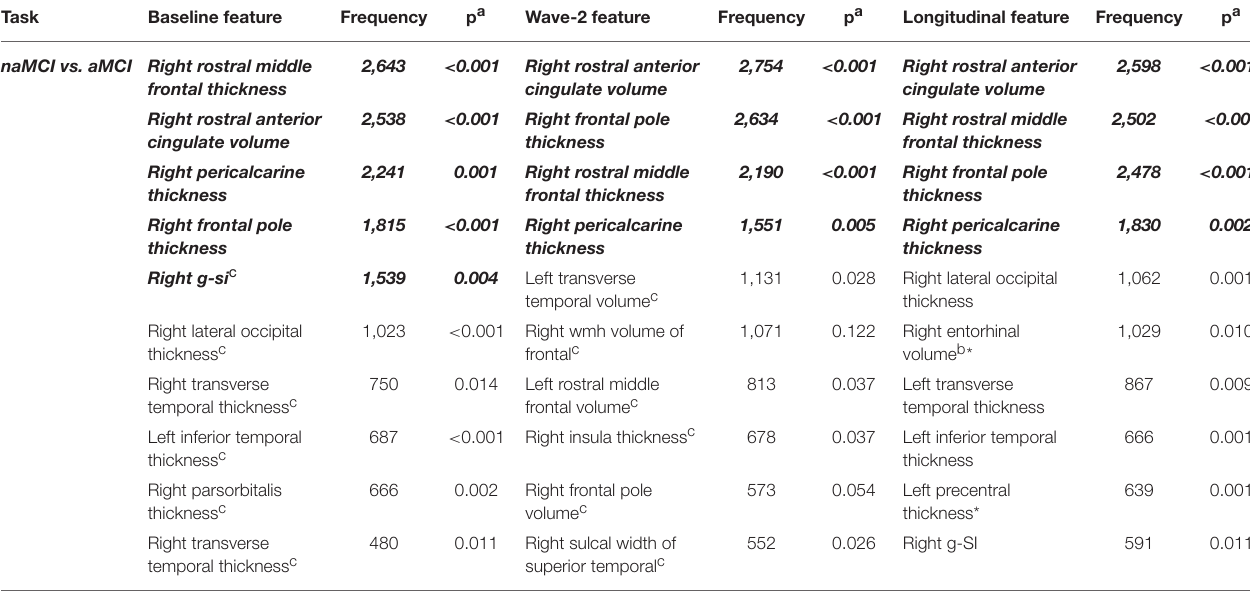
TABLE 5 | Selected features for the classification of naMCI vs. aMCI.